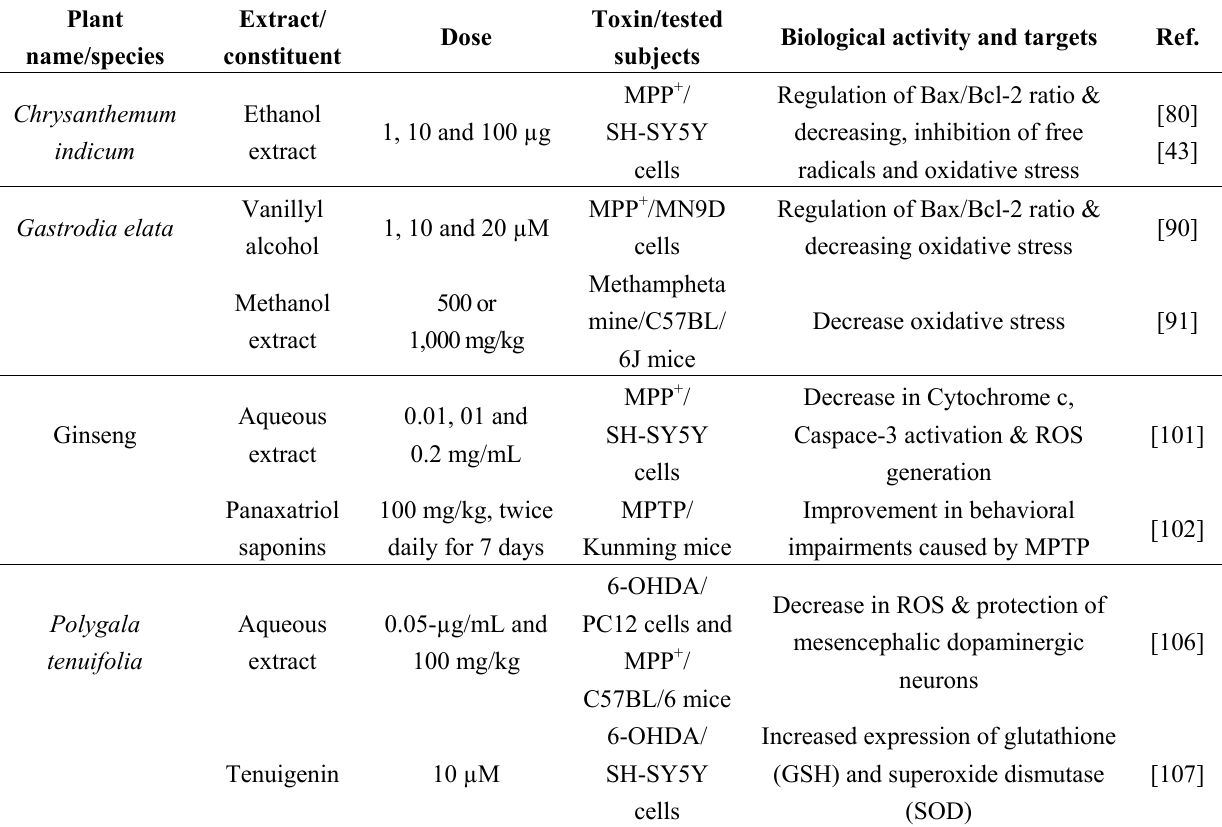
Table 1. Summary of recent antioxidant herbal products reported to be neuroprotective in experimental models of Parkinson’s